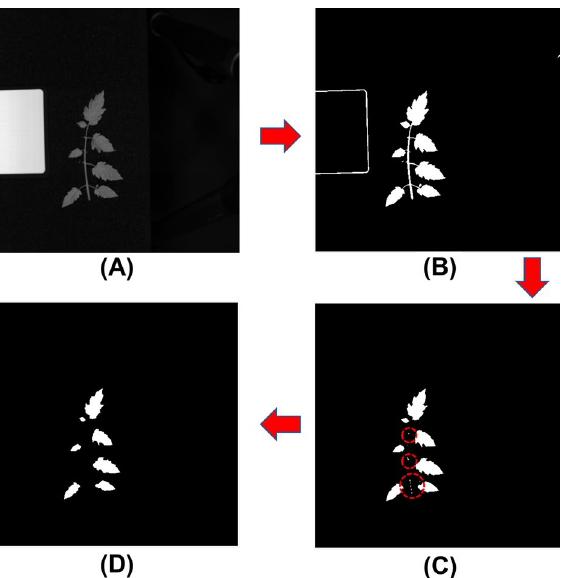
Figure 1. Spectral extraction process for hyperspectral images: ( A ) 780 nm grayscale image; ( B ) Threshold segmentation of background and leaf to obtain a binary image; ( C ) Removal of the border of the white reference panel and stem region by using image morphological analysis; ( D ) Removal of residual noise to obtain the mask